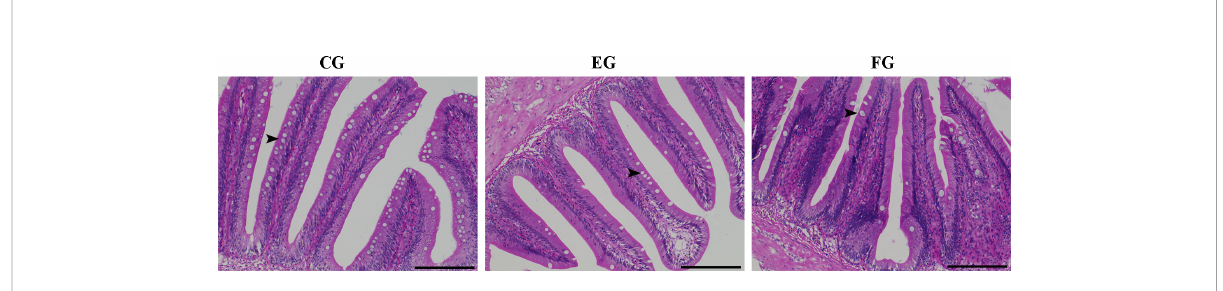
FIGURE 8 Histopathological changes showing the comparative histology midgut tissues of grass carp fed with different treatments (control (CG), enro fl oxacin (EG) and fl orfenicol (FG)) after two weeks. Representative images of gut tissues were stained by H&E and then analyzed by light microscopy. Arrows referred to goblet cell. Bars are 100 m m.